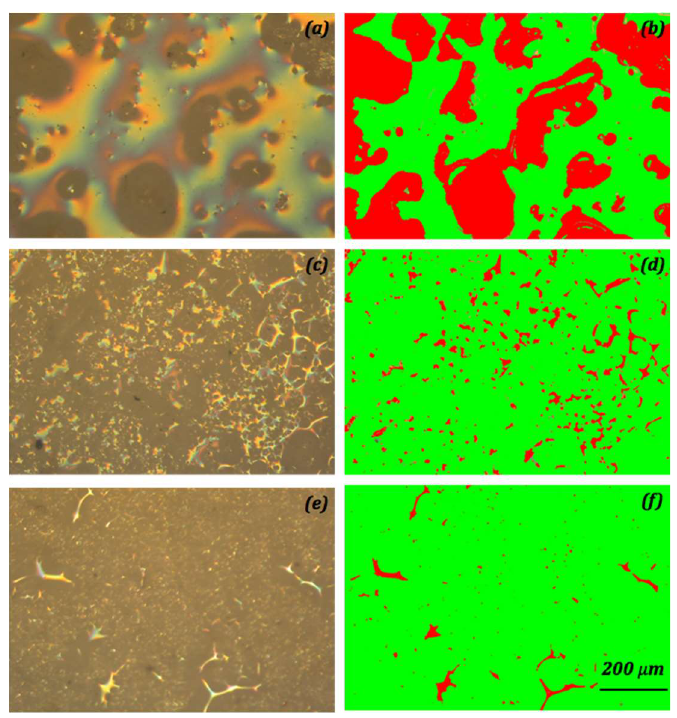
Figure 7. Optical microscopy and processed images for adhesion counting for ( a ) and ( b ) AR, ( c ) and ( d ) Texture 1 and ( e ) and ( f ) Texture 2 surfaces.